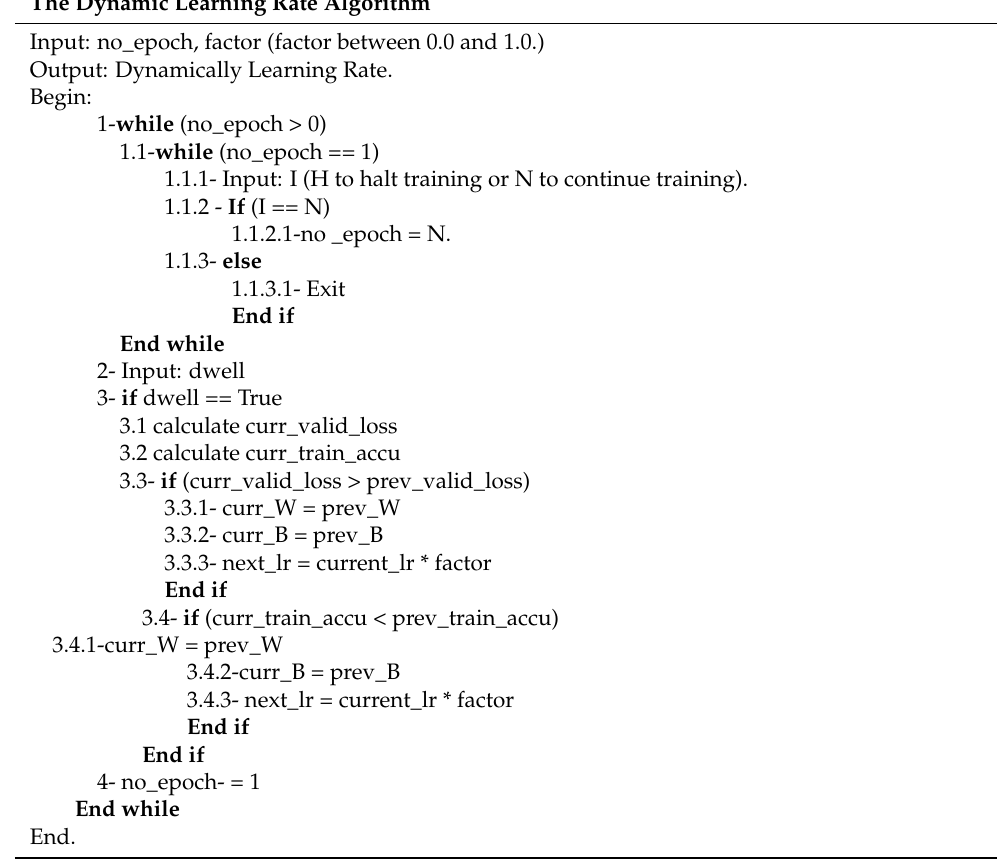
Table 1. The dynamic LR algorithm. The Dynamic Learning Rate